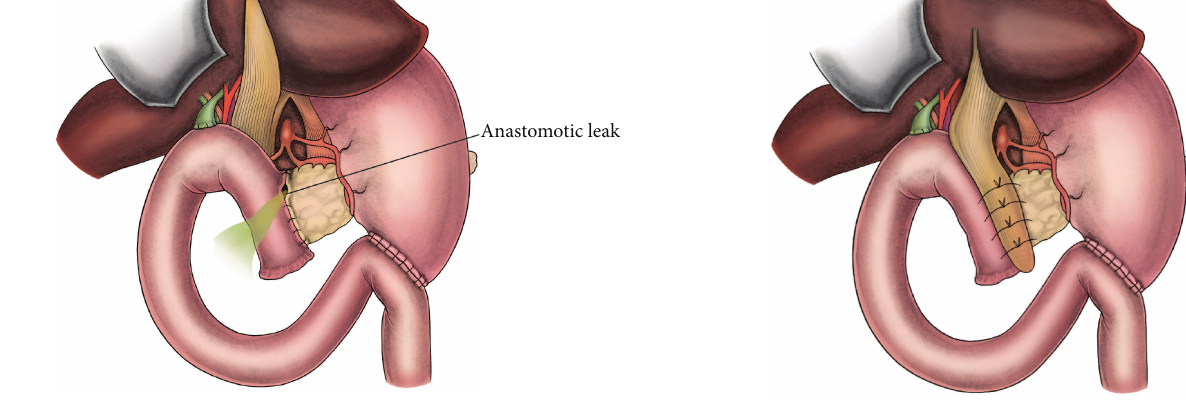
Figure 3: Gently ligated sutures serve to keep the teres hepatis patch in